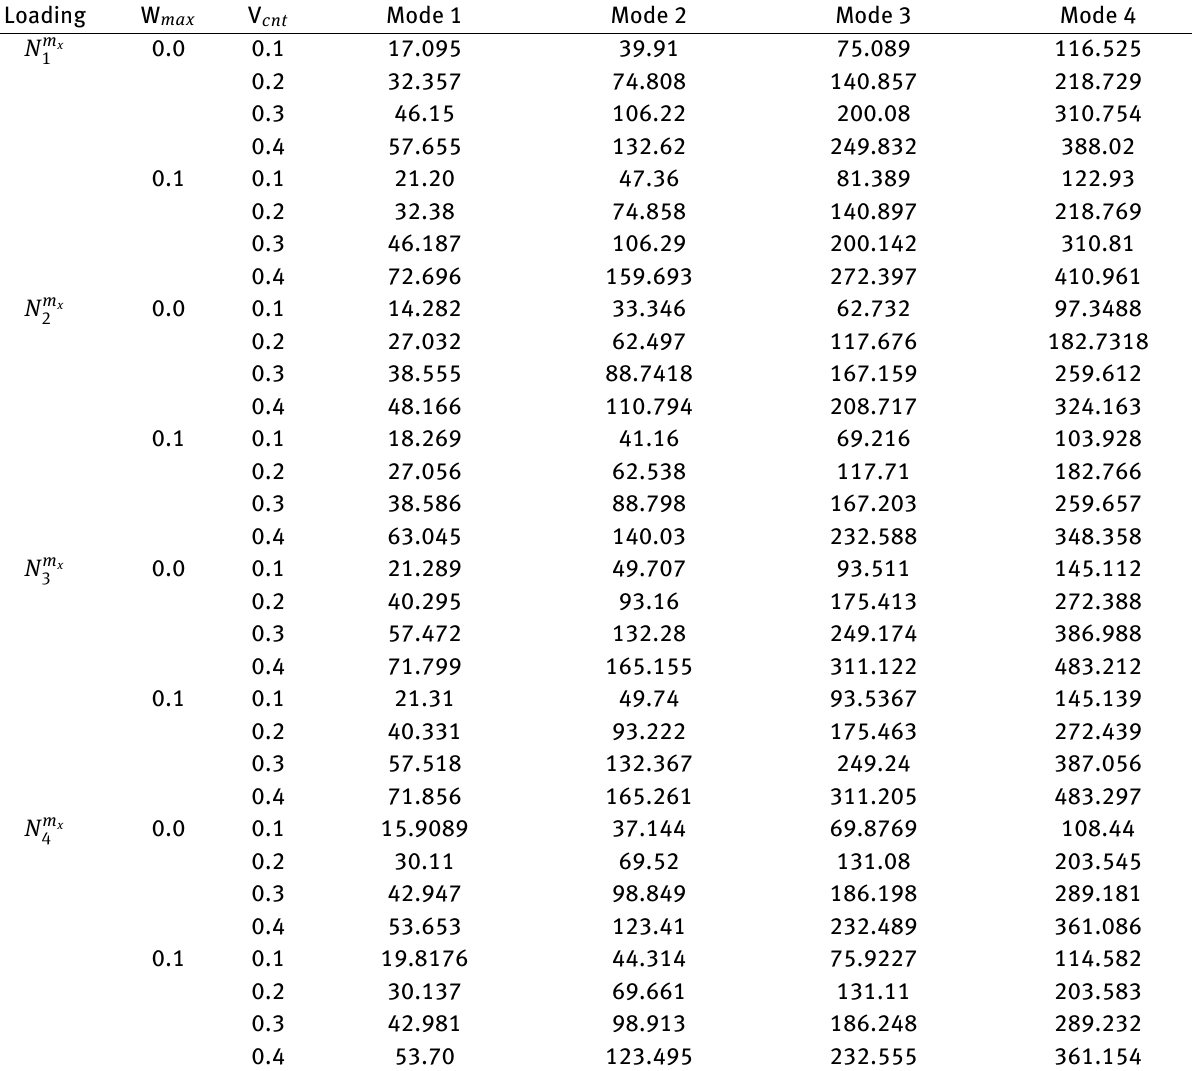
Table 6: Linear and nonlinear non-dimensionalised CBL variation for different SWCNT volume fraction